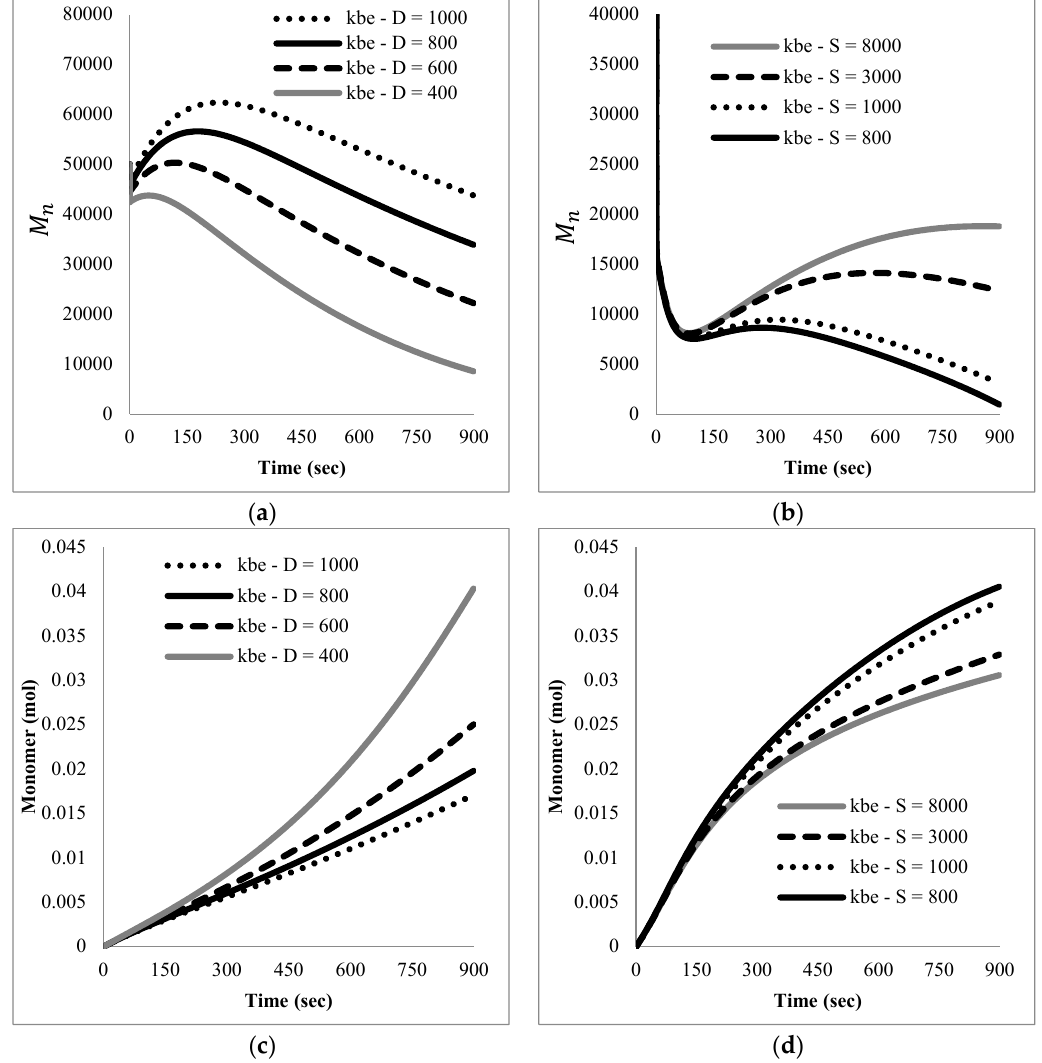
Figure 7. Effect of the variation of the chain-end scission coefficient, k be , value on the pyrolysis M n evolution of ( a ) dead polymer and ( b ) dormant polymer, and on the monomer generation of ( c ) dead polymer and ( d ) dormant polymer.